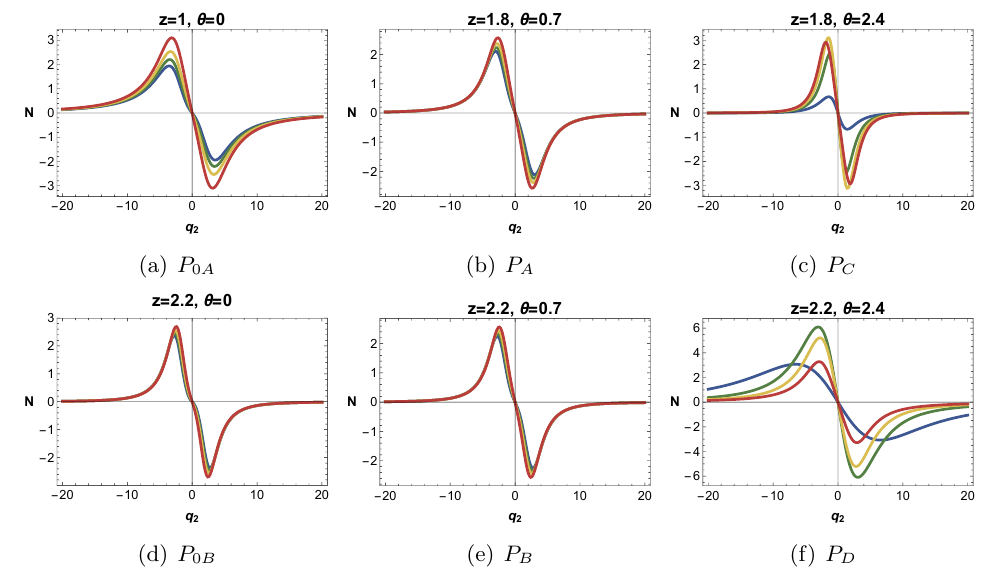
Figure 25 . Temperature evolution for N ( q 2 ) for di(cid:11)erent ( z; (cid:18) ). Each curves corresponds to T = 0 : 04 ; 0 : 1 ; 0 : 16 ; 0 : 24 for blue, green, yellow, and red respectively. We used q (cid:31) = 5.